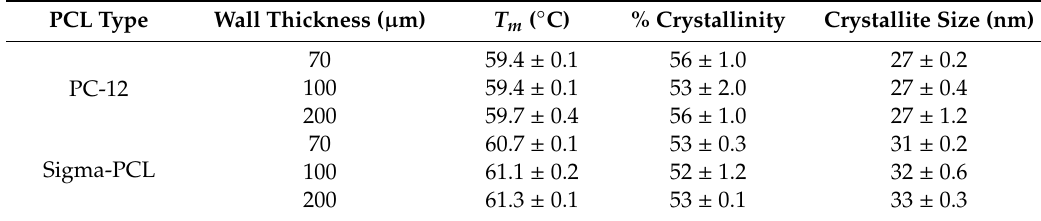
Table 1. Thermal properties of PCL extruded tubes from DSC analysis.